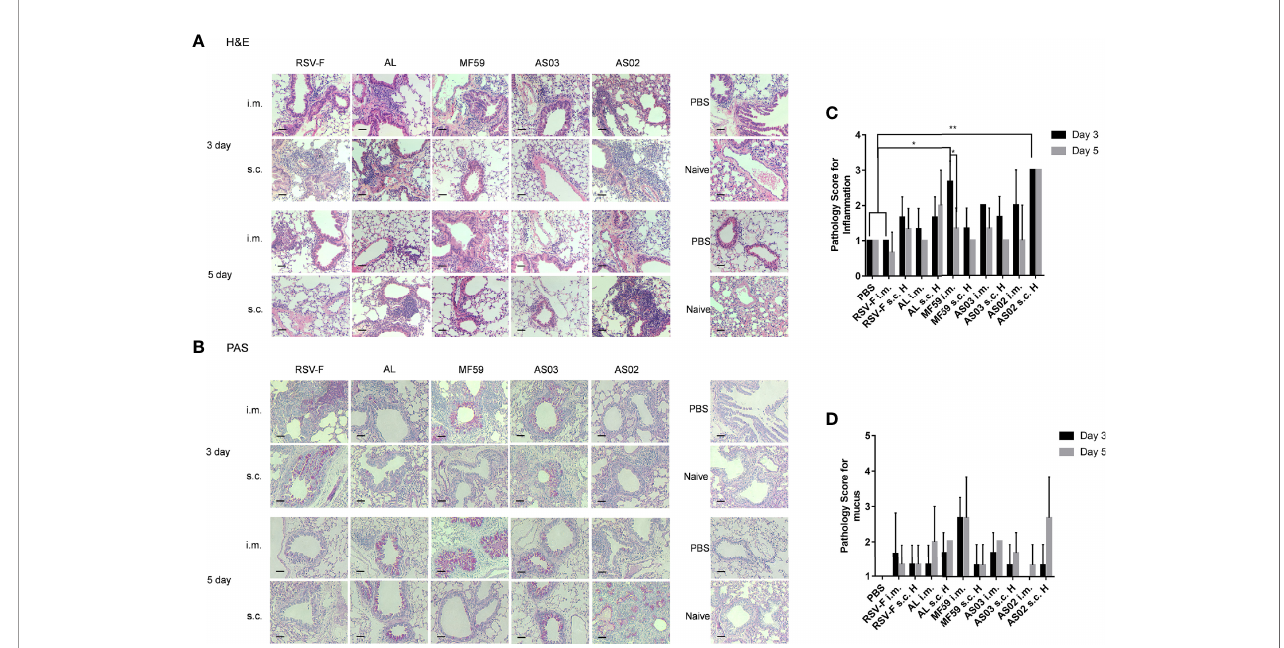
FIGURE 7 | Histopathological changes of mouse lungs after RSV challenge. Lungs were collected from mice on day 3 or 5 post-challenge and tissue sections were stained with H&E (A) and PAS (B) to assess pulmonary histopathologic changes. Each panel (x200 magni fi cation) represented an individual mouse from the indicated group. PBS, PBS control mice with RSV infection. Naïve, unimmunized and unchallenged mice. Scale bar: 200 m m. (C) Pathology score for in fl ammation. In fl ammation responses on H&E stained tissue sections were scored on a scale of 0 – 3 according to diagnostic criteria (34). (D) Pathology score for mucus. PAS stained slides were scored for goblet cell proliferation and mucus on a scale of 1 – 4 (35). Results (n= 3 per group) were presented as mean ± SD and statistical signi fi cance was performed by two-way ANOVA with Tukey ’ s multiple comparisons test. *P< 0.05, **P